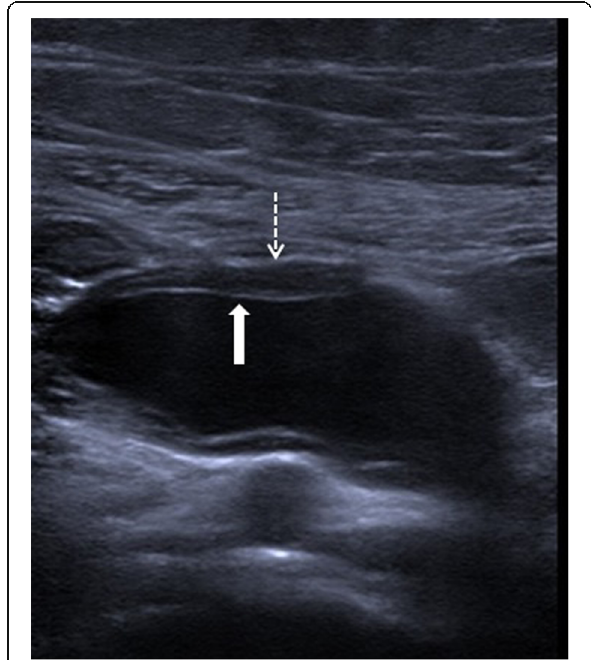
Fig. 27 An 8-year-old male patient presenting to the emergency department (ED) with right lower quadrant pain. Axial view US image shows a cystic mass with thick wall suggested for “ double- wall ” sign: The mucosa appears hyperechoic (arrow) whereas the muscular layer hypoechoic (dashed-line arrow). Laparoscopic surgery and histopathologic examination confirmed the ileal duplication cyst causing intestinal obstruction